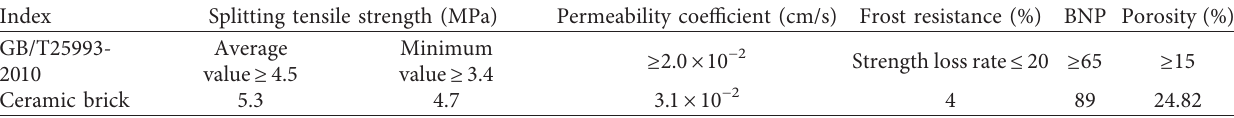
Table 1: The main properties of ceramic permeable brick.